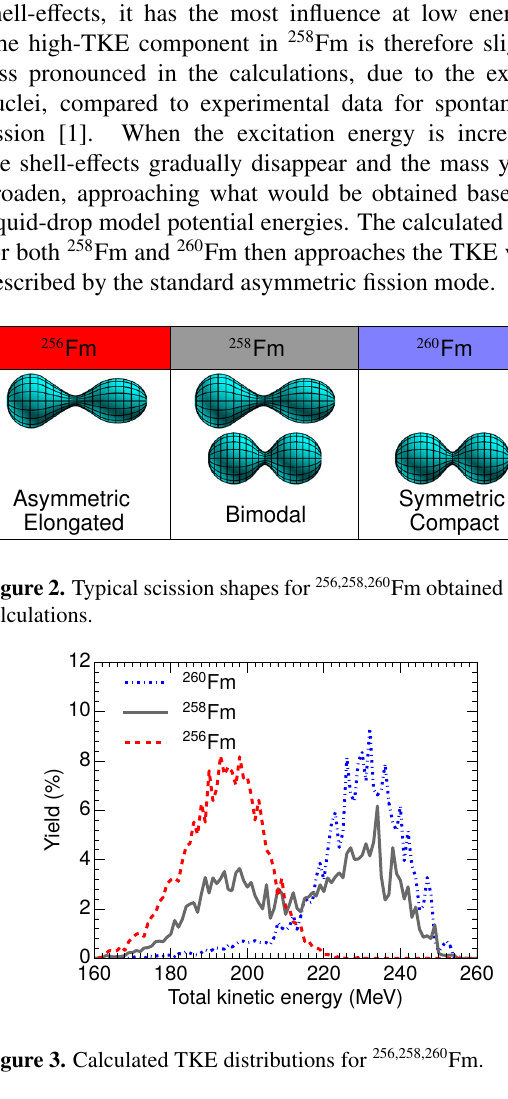
Figure 3. Calculated TKE distributions for 256 , 258 , 260